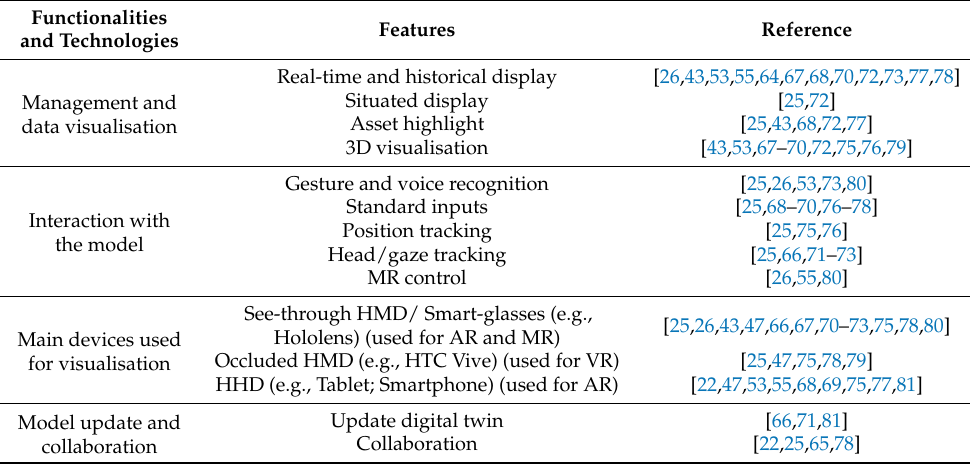
Table 6. Categorical review of the improvements brought by XR